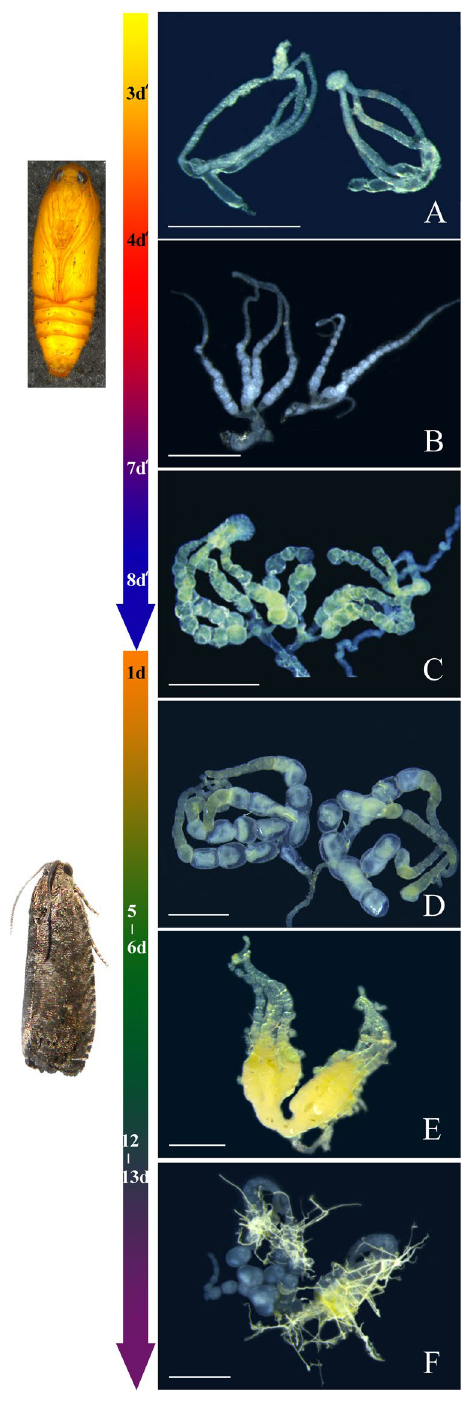
Figure 4. Ovarian classification of OFM females (d’: days after pupation; d: days after emergence). Scales = 1.0 mm. ( A ) Initial stage; ( B ) Transparent stage; ( C ) Yolk deposition prophase; ( D ) Yolk deposition stage; ( E ) Egg maturation & oviposition stage; ( F ) Terminal stage of